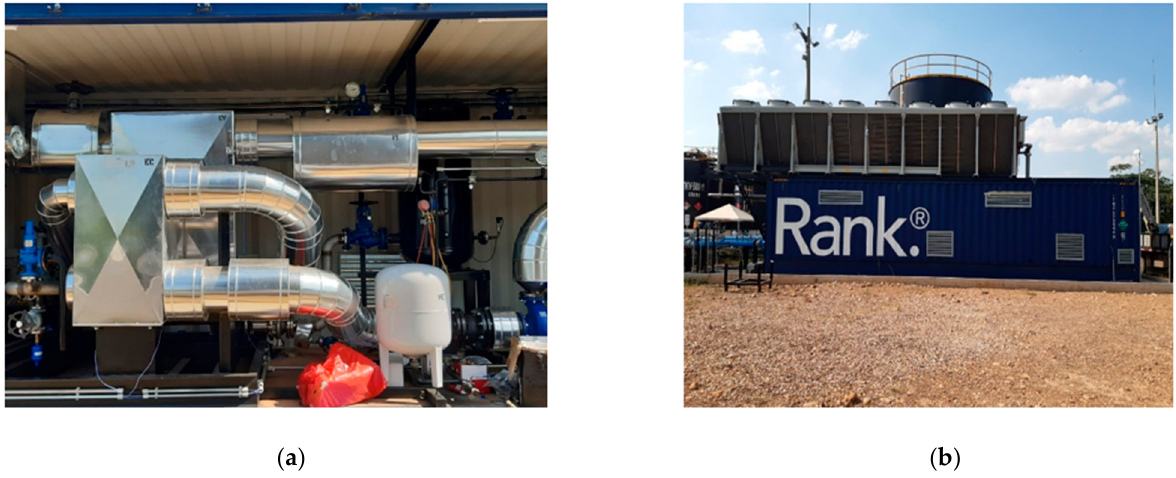
Figure 5. An oilfield ORC system: ( a ) internal view; ( b ) external view with condenser positioned on top.